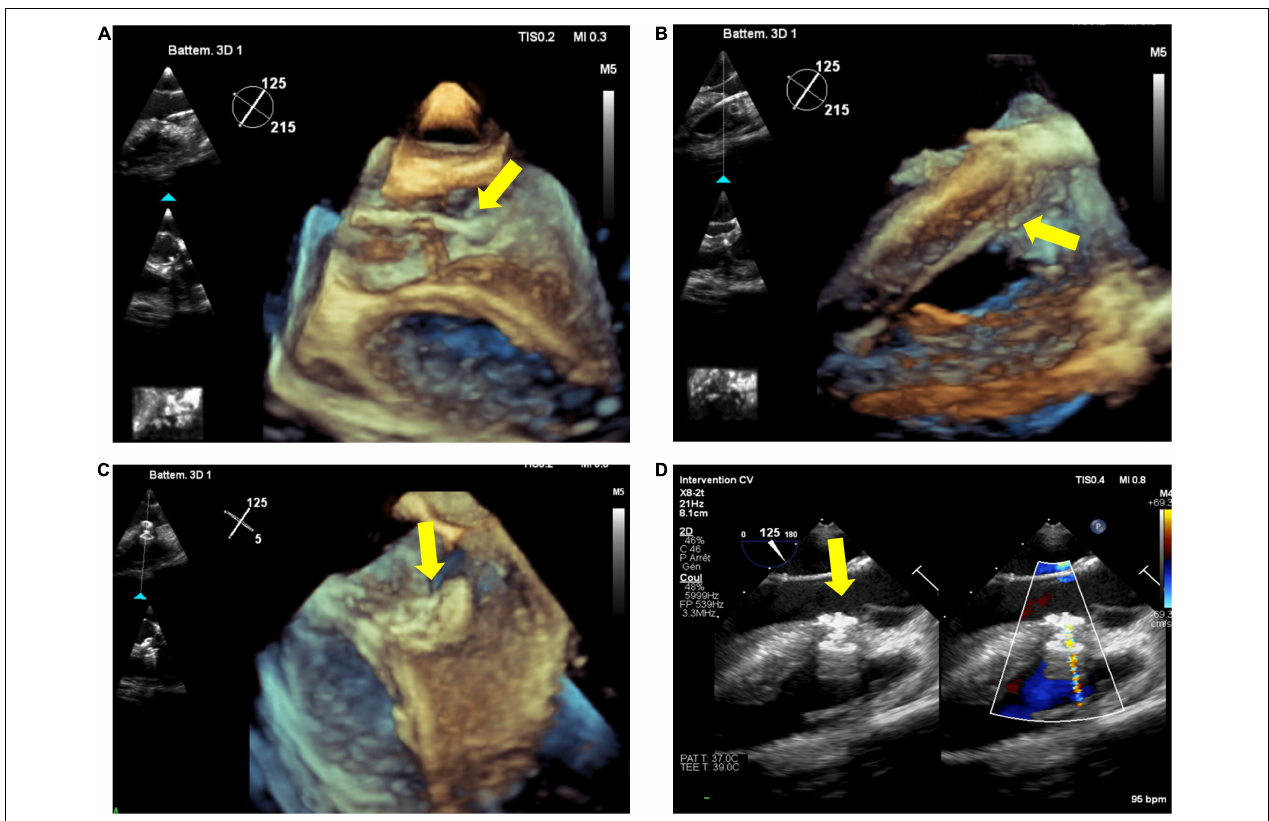
FIGURE 2 | Percutaneous closure of perimembranous ventricular septal defect (pmVSD). Transesophageal echocardiography (TEE), especially 3D, permits visualization of catheter passage through the aortic valve (A) and in the right ventricle (B) (yellow arrow), and live monitoring during (C) and after device release (D) (yellow